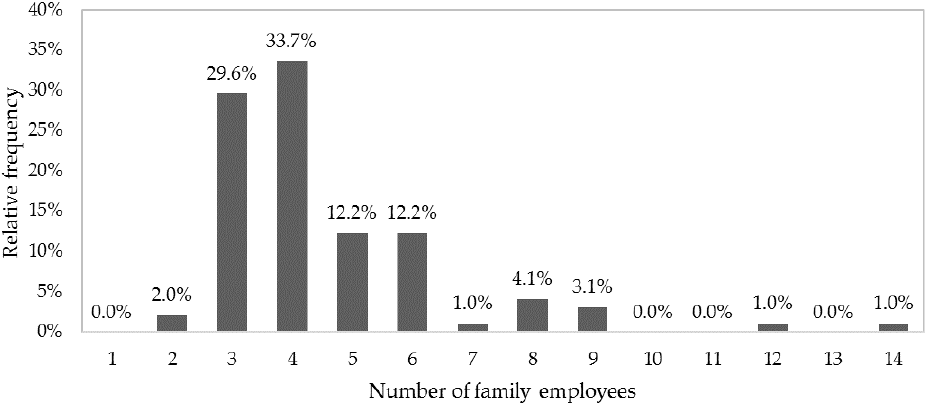
Figure 1. The relative frequencies of the numbers of employed family members.